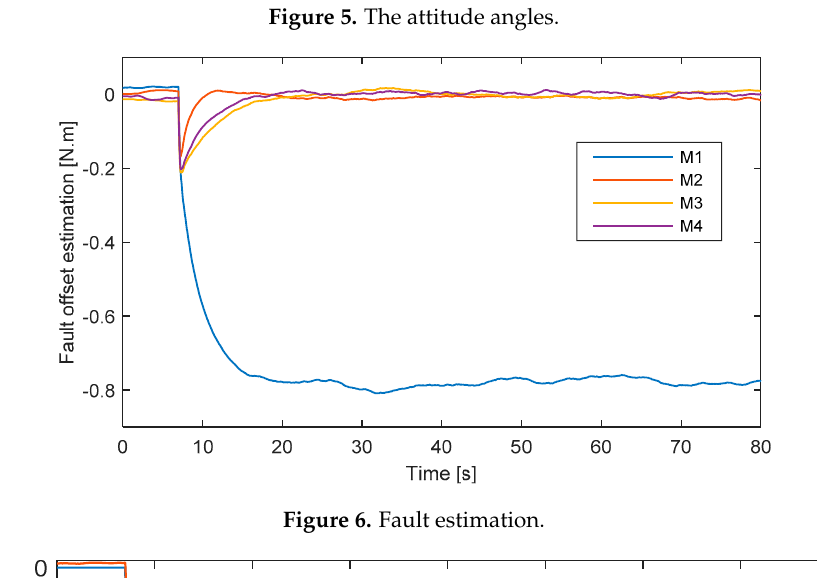
Figure 6. Fault estimation.